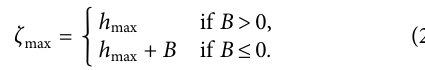
Frontiers in Earth Science |